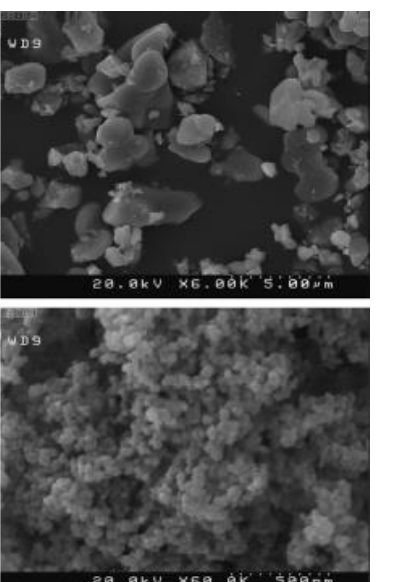
A list of factors that influence the tensile value is mentioned and discussed in detail.